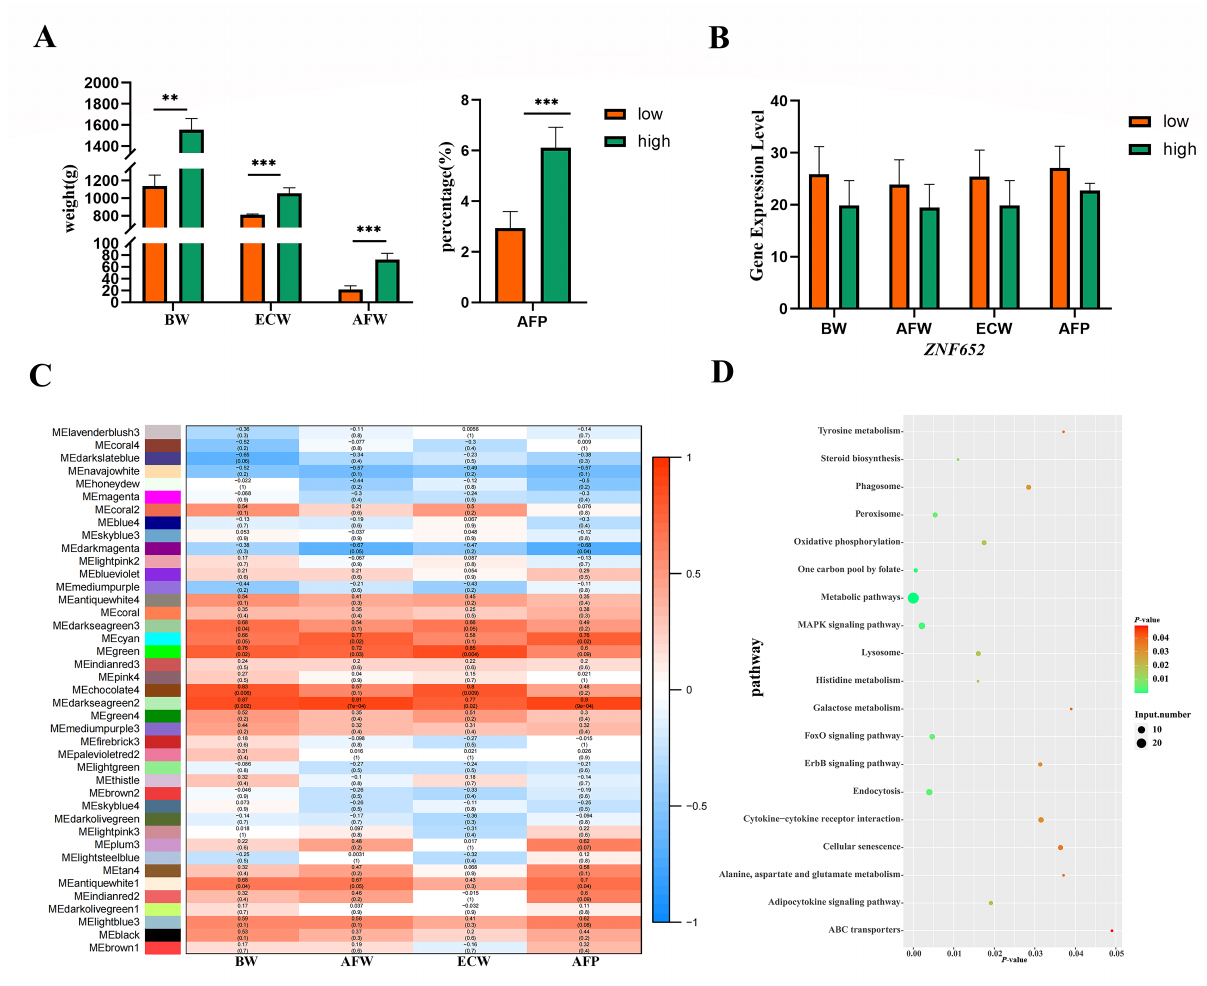
Figure 8. Expression levels of ZNF625 in high and low abdominal fat percentage (AFP) groups. ( A ) Phenotypes of the high and low AFP groups, ** p < 0.01, *** p < 0.001. ( B ) ZNF652 expression levels in the high and low AFP groups. ( C ) Heatmap showing module-trait associations. Each cell contains the corresponding correlation and p -value in parentheses. Red and blue colors represent positive and negative correlations. ( D ) Kyoto Encyclopedia of Genes and Genomes analyses of significantly module